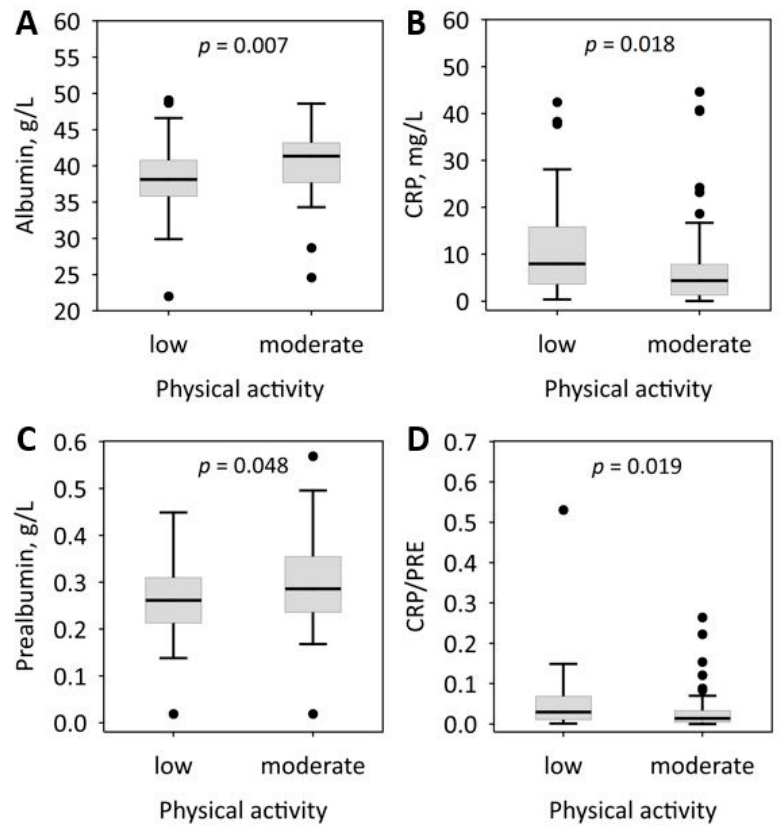
Figure 1. Associations between the level of physical activity reported by patients and the selected markers of malnutrition and inflammation: albumin ( A ); C-reactive protein (CRP) ( B ); prealbumin ( C ); and C-reactive protein to prealbumin ratio (CRP/PRE) ( D ). Data are shown as median, lower-upper quartile (box), non-outlier range (whiskers), and outliers (dots).